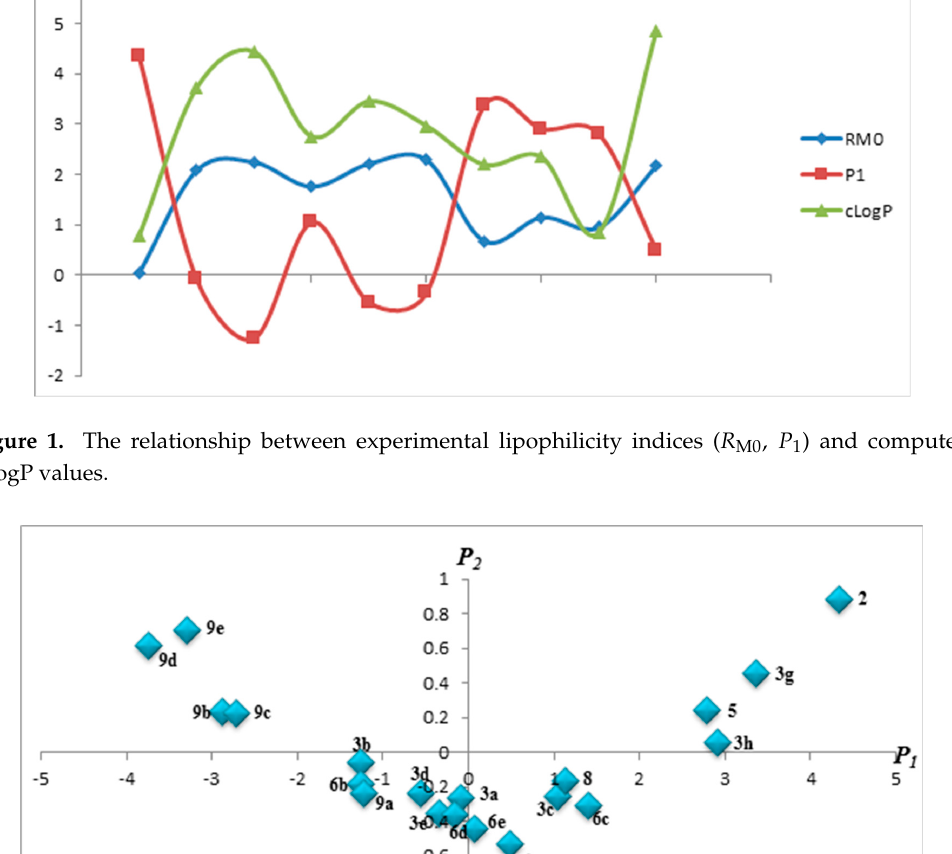
Figure 2. Congeneric lipophilicity chart (2D plot) obtained by plotting the scores corresponding to P 1 and P 2 . The highest values of the lipophilicity parameters were obtained for compounds 9d , 9e , 9b , 9c ,